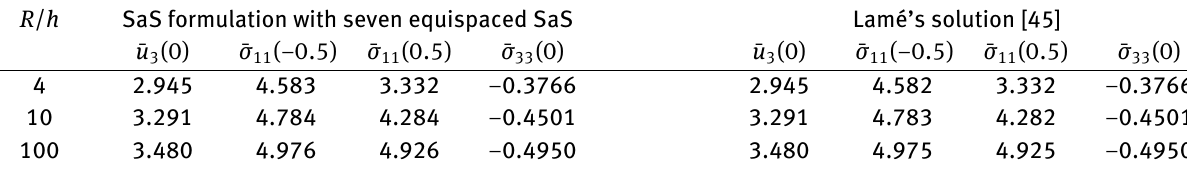
Table 5: Convergence results for a spherical shell with R / h = 100 through the use of three equispaced SaS. Mesh ¯ ε 11